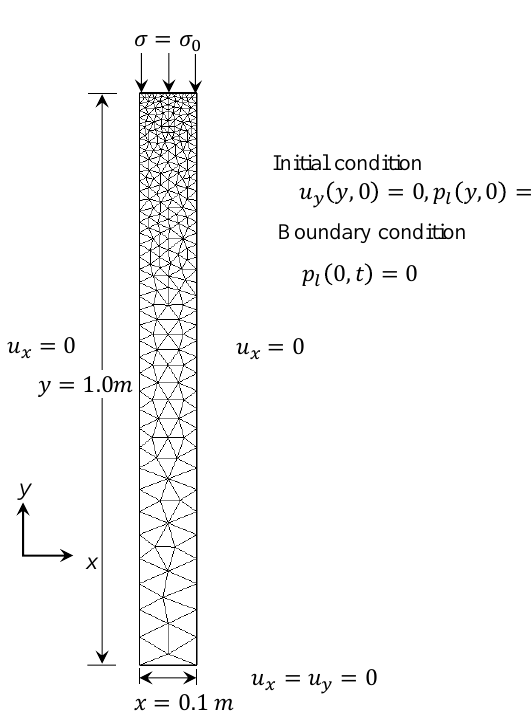
Figure 3. Initial and boundary condition of Terzaghi’s 1D consolidation solution.